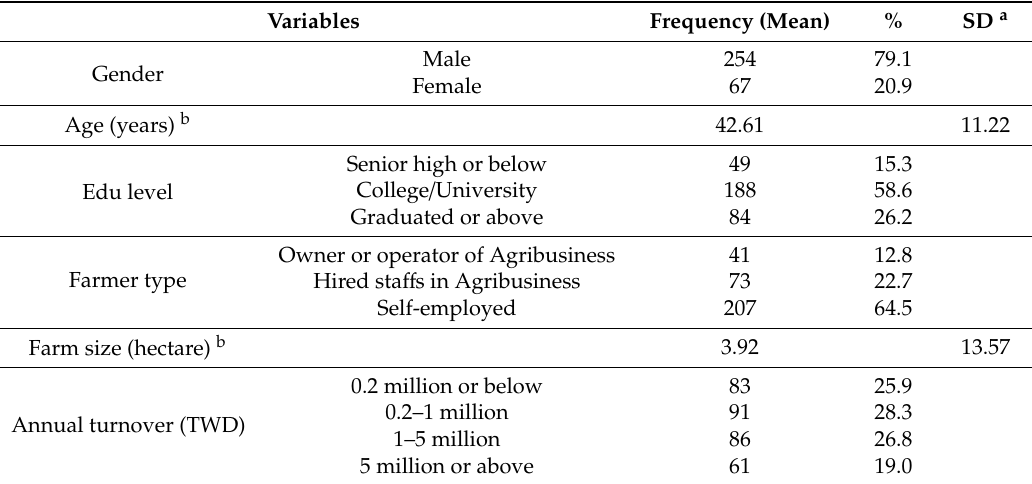
Table 1. Descriptive statistics of sample characteristics ( n =